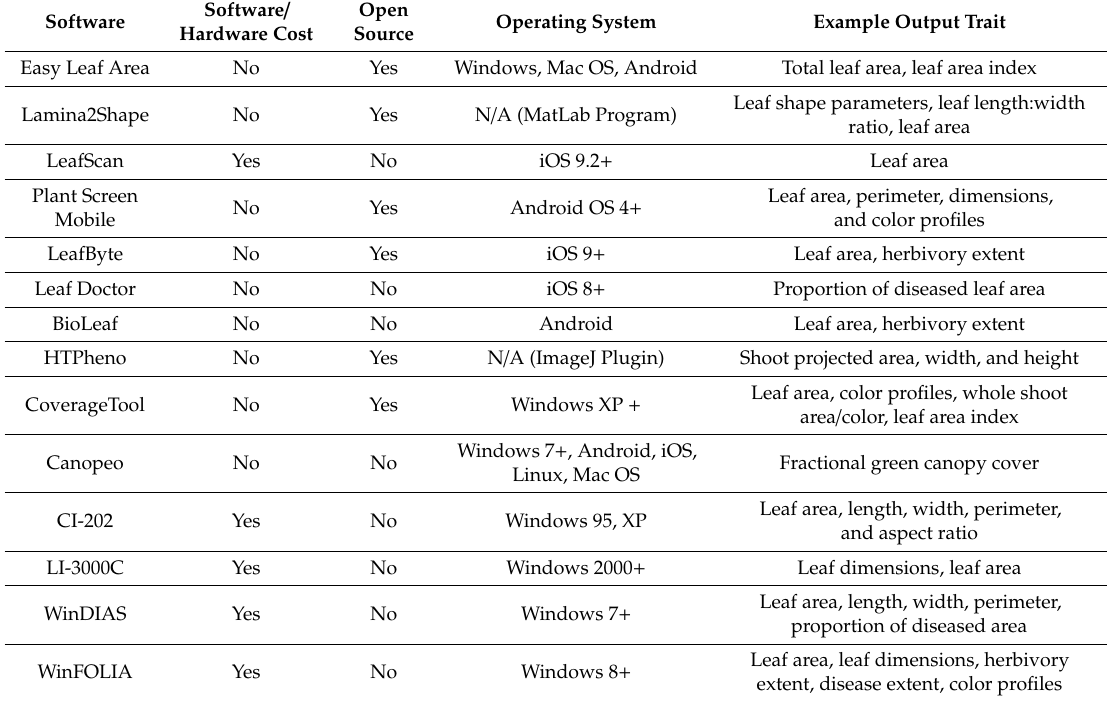
Table 1. Commonly used image-based tools for shoot phenotyping in